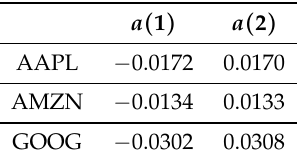
Table 5. a ( i ) is the average of the upward or downward mid-price movements. Following our previous convention, the first state will be associated with the mean of all downward mid-price movements and the second state will be associated with the mean of all upward mid-price